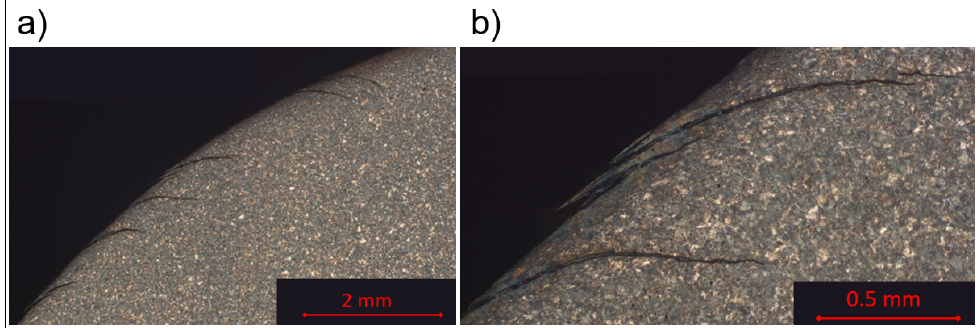
Figure 18. Thin section of rail gauge corner (perpendicular to the running direction of the wheel to match the simulations sketched in Figure 8) taken after 310,000 load cycles (wheel passes) at the measurement cross-section, ( a ) head checks with 0.62 mm depth, ( b ) detailed view.